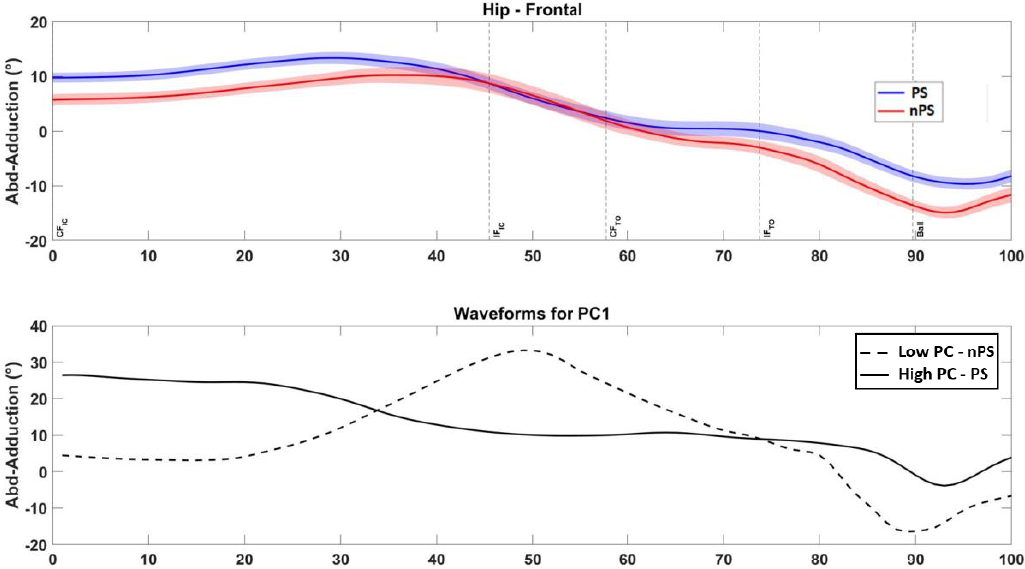
Figure A3. LOW DIVE — Lower Limb, Ipsilateral: in the bottom row, preferred side waveform is represented by the high PC (solid line) for this kinematic variable. Note: PS = preferred diving side; nPS = non-preferred diving side; PC = principal component; IC = initial contact; TO = toe-off, CF = contralateral foot; IF = ipsilateral foot; Ball = ball contact.